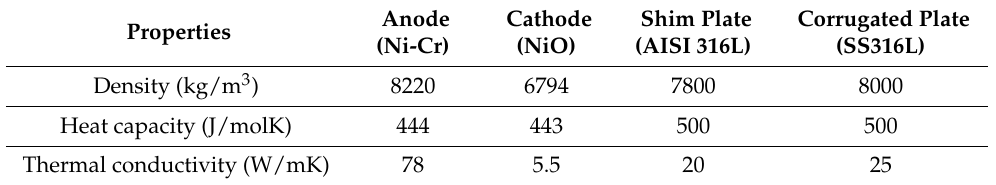
Table A6. Thermal properties of MCFCs